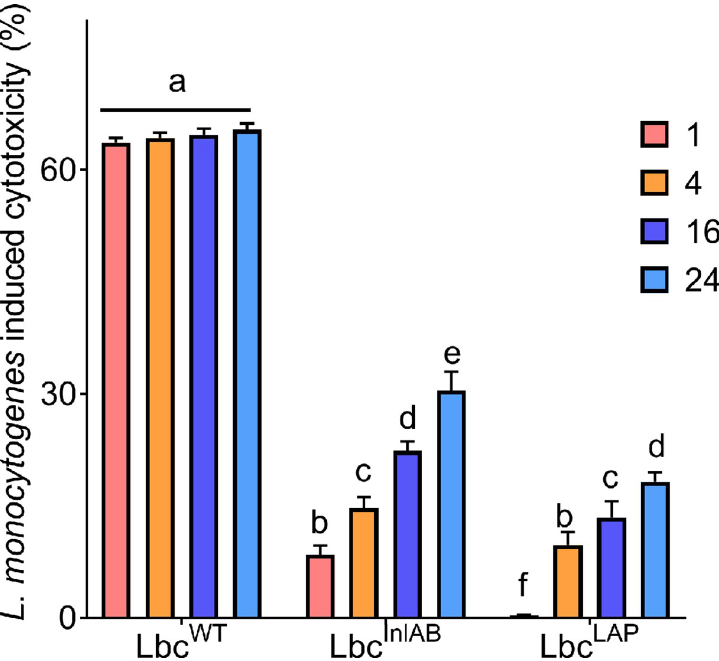
Fig 4. Cytotoxicity of Listeria monocytogenes (Lm) on Caco-2 cells pre-exposed to L . casei over time. Cytotoxicity value for L . monocytogenes treatment in the absence of L . casei strains was 70.25%. Data are averages of three experiments run in duplicates. Error bars are standard deviations of averages of the three independent experiments. Bars marked with different letters (a, b, c, d, e, f) indicate significant difference at p < 0.05.